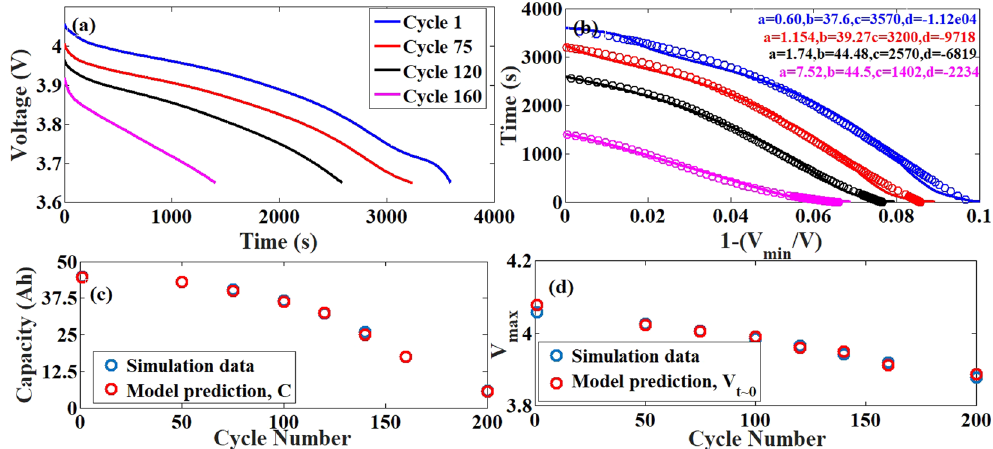
Figure 4. Comparison between simulation data and model prediction for the NG-LMO system with both Anode SEI and LMO degradation. ( a ) The discharge profiles obtained from ECT simulations using the Anode SEI and LMO dissolution model. ( b ) The reduced parameter representation of the discharge curves in the new system (bold lines) and the model prediction (circles) with the parameter values mentioned in the legend. ( c ) The comparison of the capacity loss (through available capacity) obtained from the simulations and the prediction from the model. The time taken for full discharge over a cycle is taken as a measure of the capacity. ( d ) The comparison of the resistance induced loss obtained from the simulations and the prediction from the model. The voltage at the start of discharge (V max ) is taken as a measure to predict the resistance induced loss. The maximum error between the predicted and actual data is <